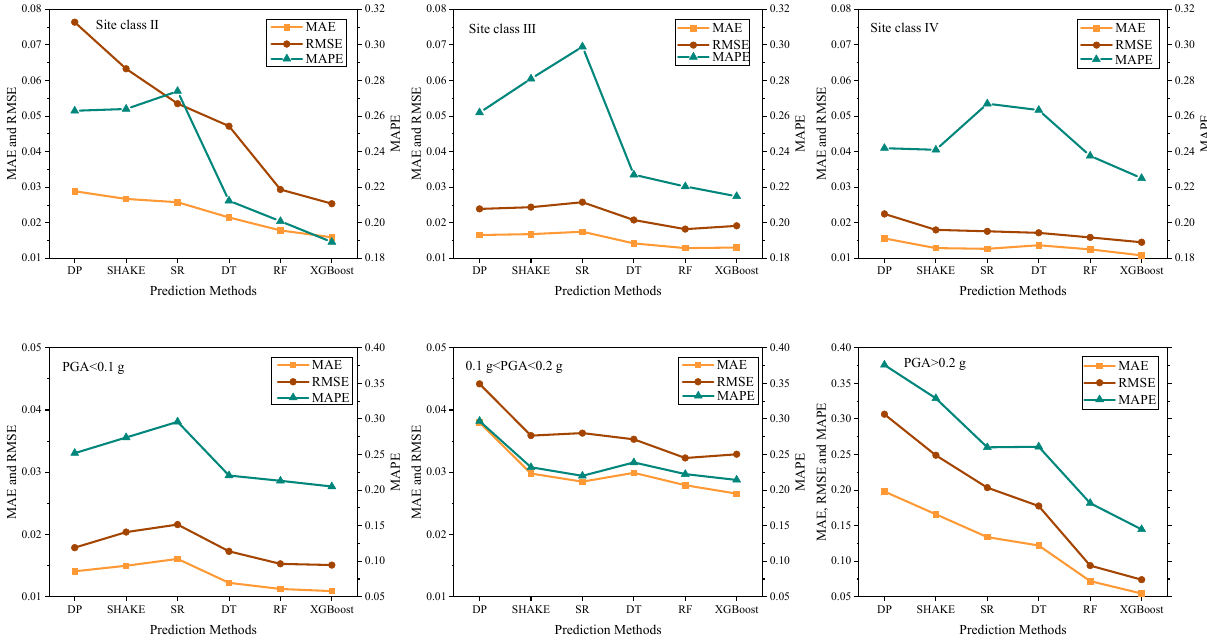
Figure 11. Comparison of prediction e ff ects of numerical simulation methods and machine learn- ing models on di ff erent site classi fi cations and di ff erent PGA intervals. models on different site classifications and different PGA